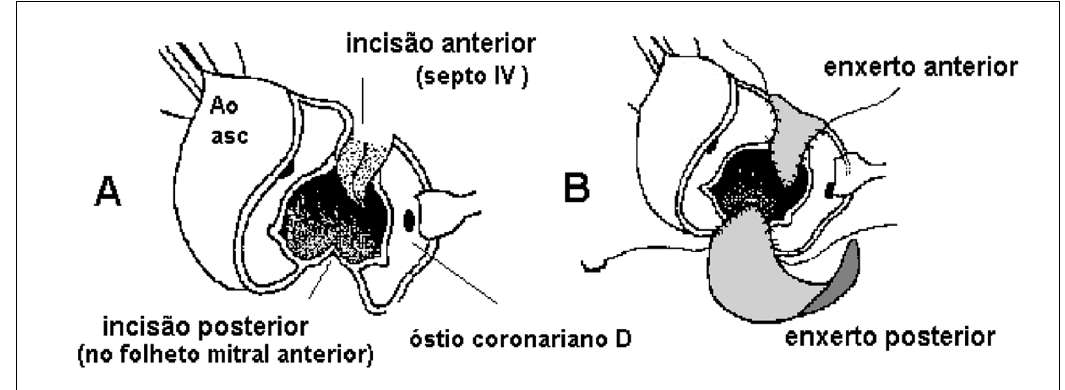
Fig. 1 - Cirurgia de ampliação simétrica. (A) Incisões posterior (contínua a linha da aortotomia) e anterior (compreendendo o septo interventricular). (B) Sutura dos enxertos de ampliação. Abreviaturas: Ao Asc: aorta ascendente; septo IV: septo interventricular; D: direito.